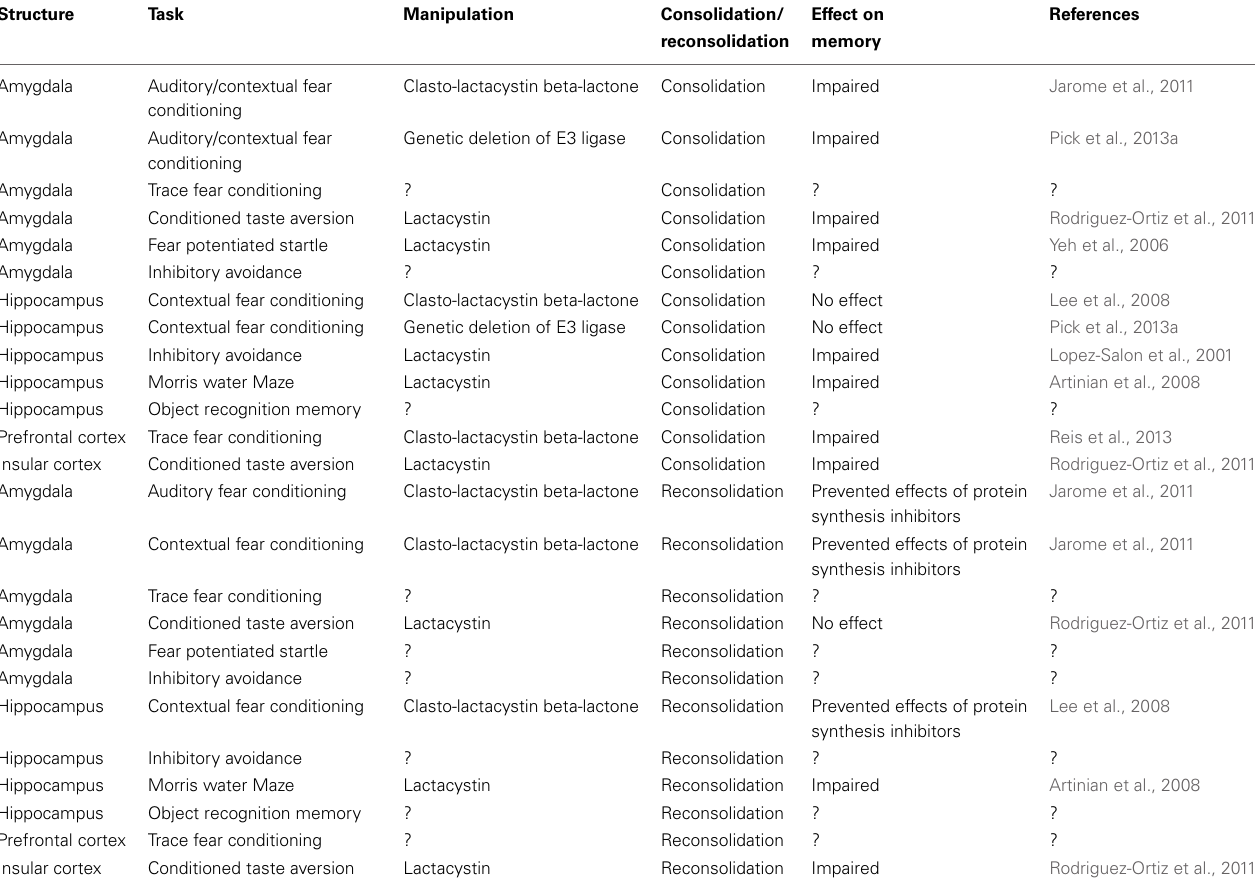
Table 2 | The role of protein degradation in memory consolidation and reconsolidation.